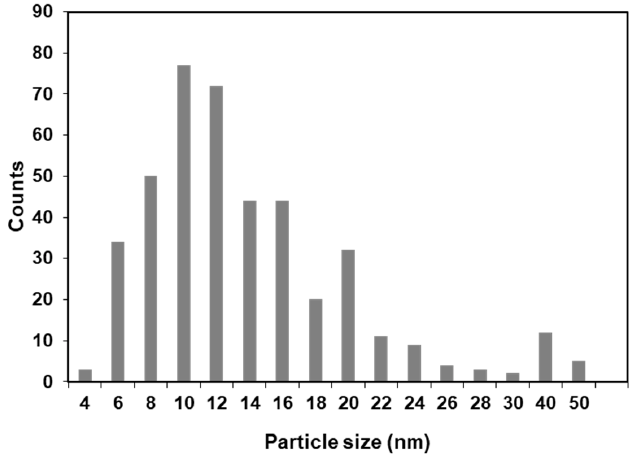
Figure 5. Particle size distribution histogram of CeO 2 NPs obtained from transmission electron microscopy (TEM) images.